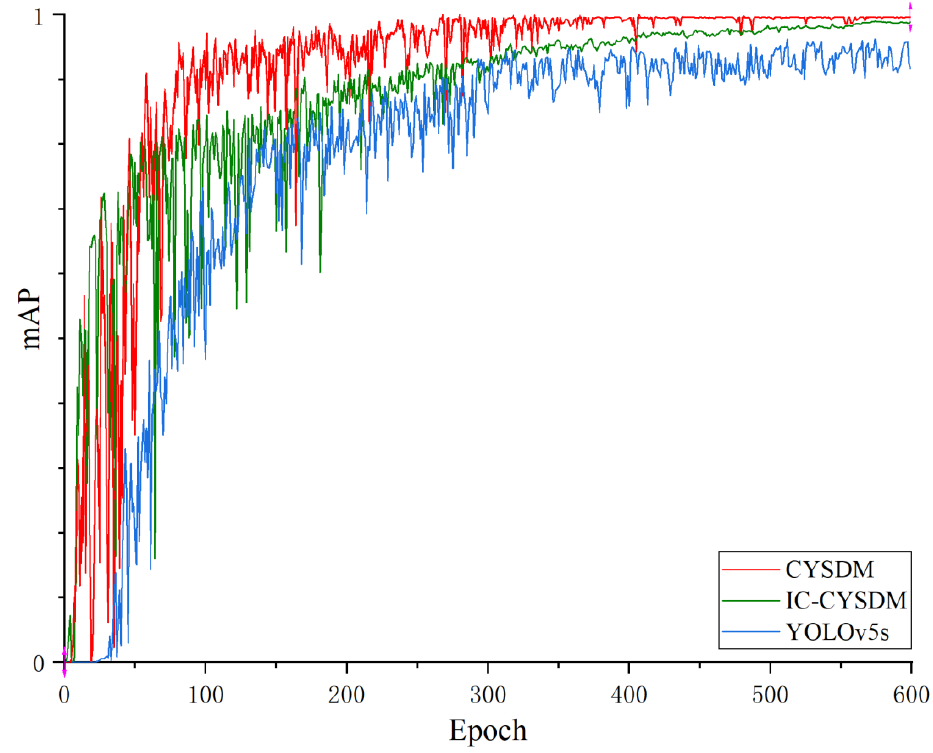
Figure 3. The mAP of the proposed method (CYSDM), the improved YOLO-based networks without considering the intra-class variation (IC-CYSDM), and the YOLOv5s algorithm.